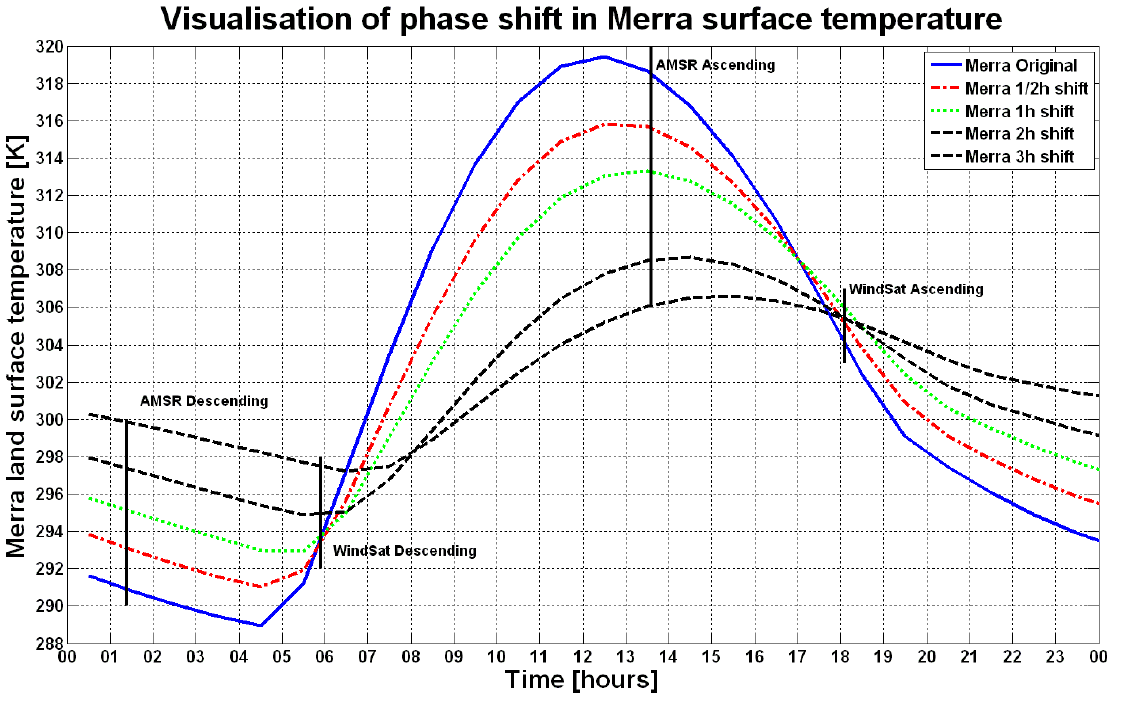
Fig. 6. Detailed diurnal land surface temperature time series from MERRA for 1 July 2009 in Oklahoma, United States of America. Different colours/line styles indicate different phase shifts which are related to different depths in the